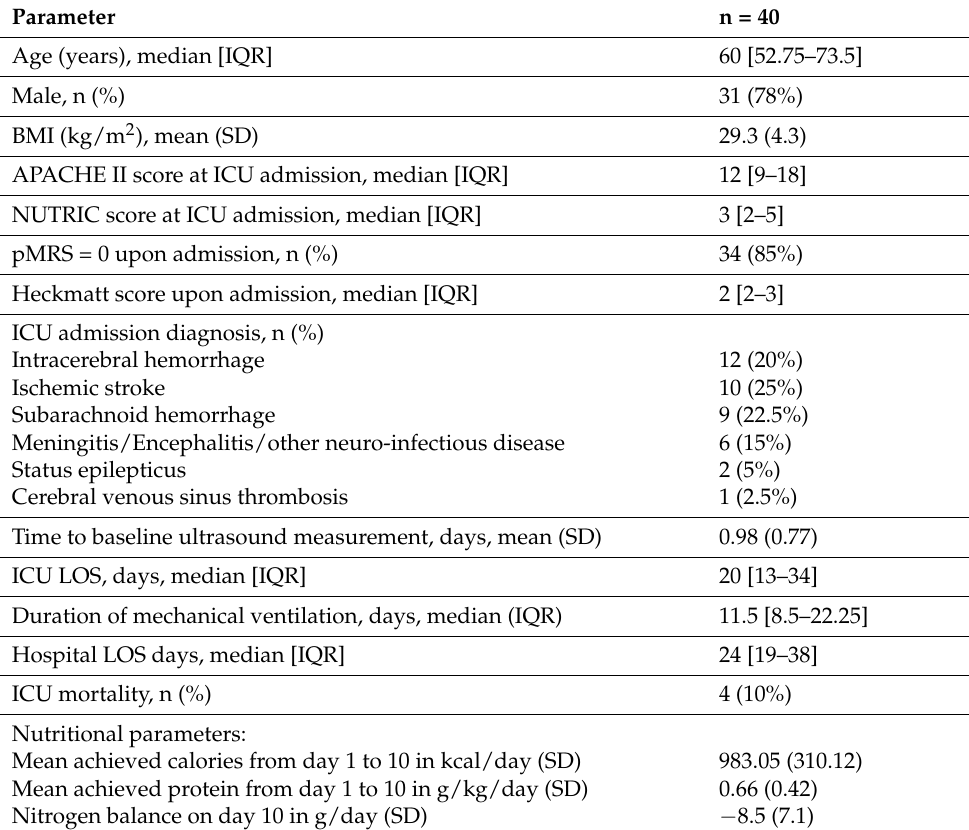
Table 1. Patient demographics and critical illness